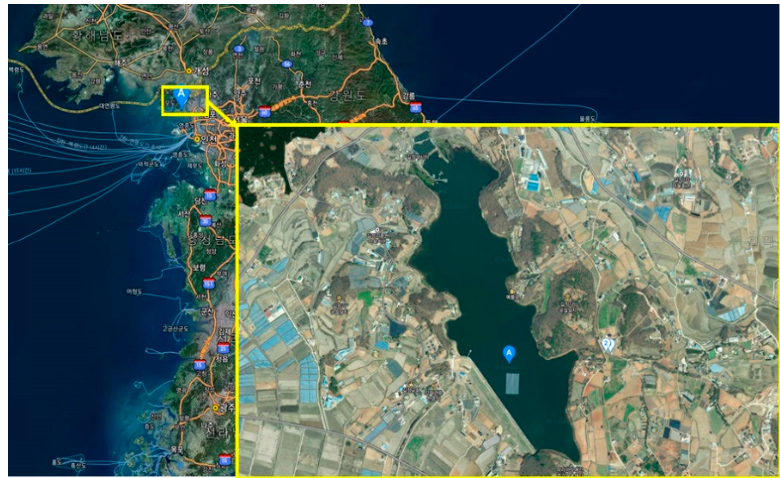
Figure 4. Location of the photovoltaic power generation structure.